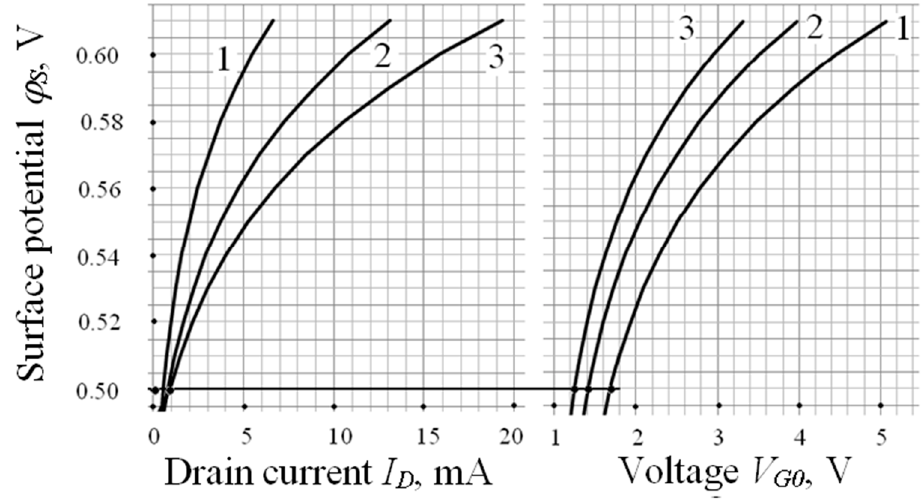
Figure 5. Dependences of values ϕ s on the current I D at different V D (1 → 0.1 V; 2 → 0.2 V; 3 → 0.3 V), and on values of V G 0 at different C 0 (1 → 30 nF/cm 2 ; 2 → 40 nF/cm 2 0.2 V; 3 → 50 nF/cm 2 ).